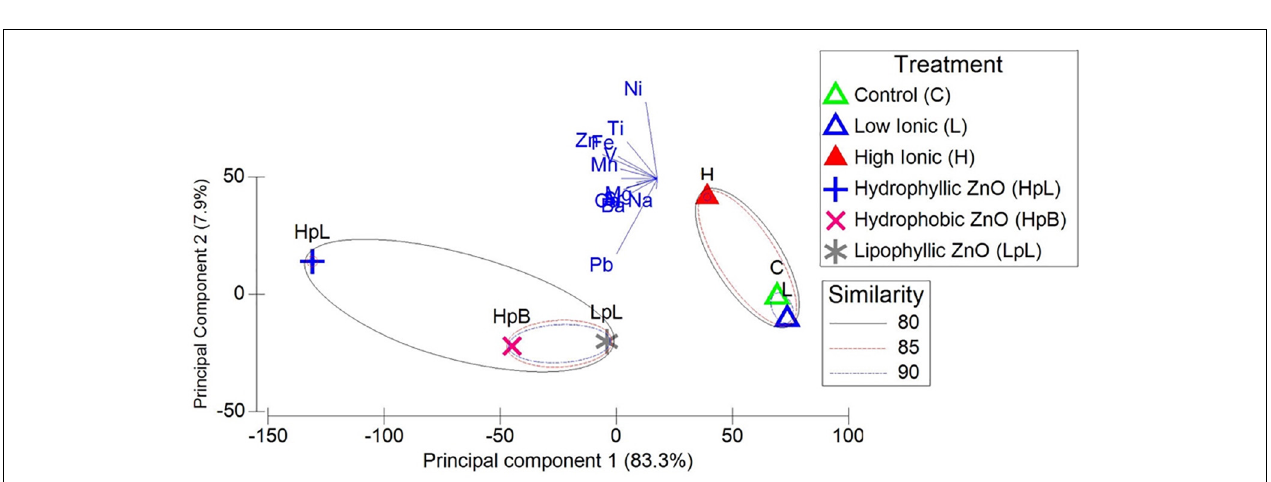
FIGURE 1 | (Left) STXM analyses of the distribution of Zn by treatment in transmission images illustrating diatoms, bacteria, and exopolymeric substances. (Right) Same image series, with biological biofilm material shown in blue and Zn in red.